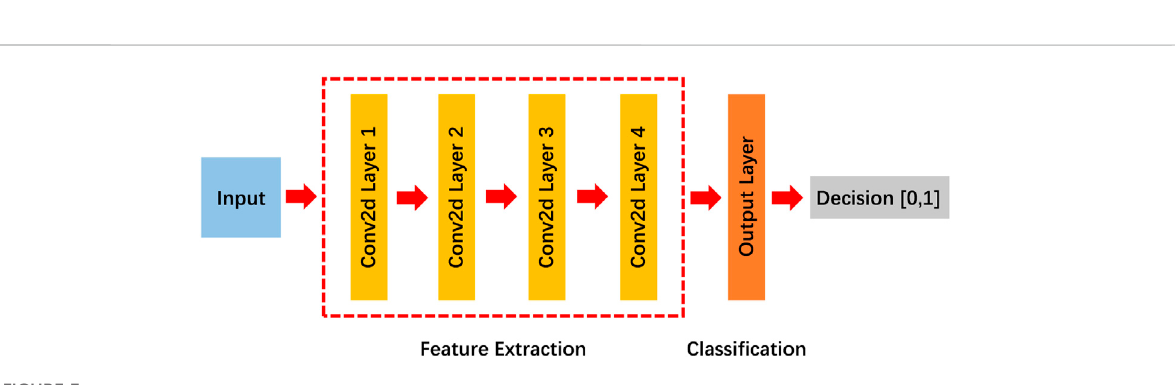
FIGURE 3 The detailed architecture of the discriminator, 4 convolutional layers are used to extract the features of the input data, and fi nally, a convolutional layer is added to output the discriminant